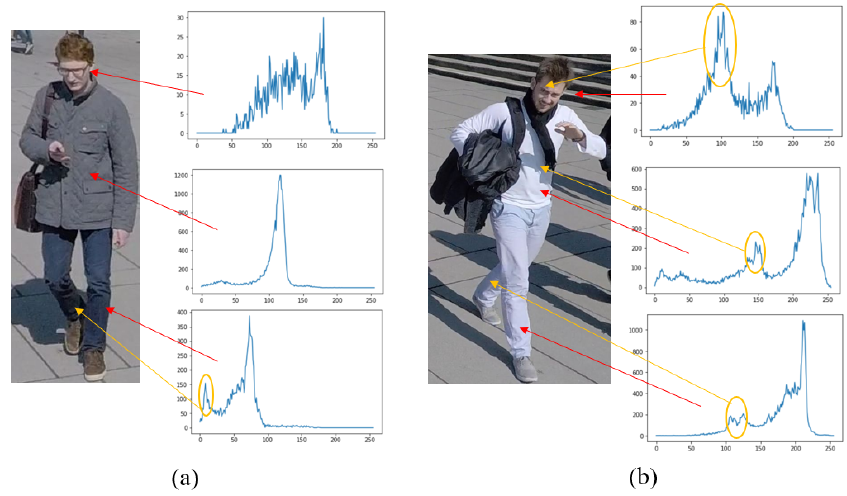
Figure 3. The correlation between shadows and peaks in the L channel histograms of face, upper clothes, and pants subregions: ( a ) prominent shadows appear only on pants and ( b ) shadows appear in every subregion. Yellow arrows show correspondence between histogram regions and shadows in